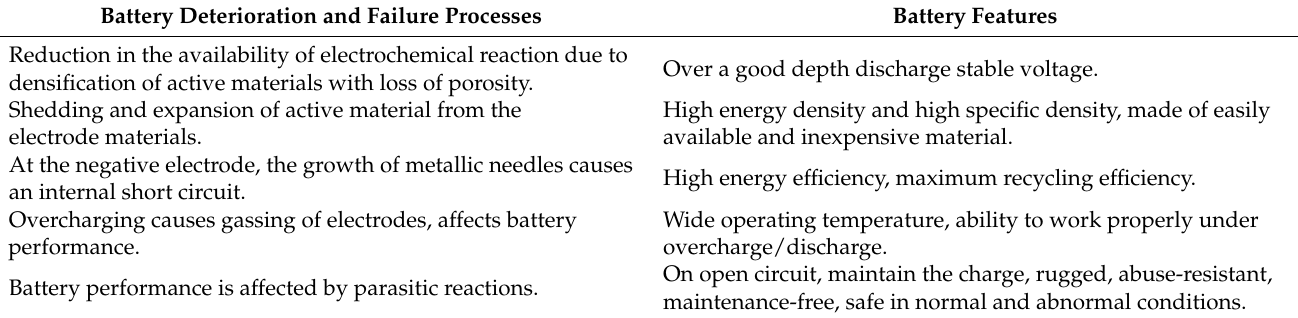
Table 1. Battery deterioration and failure